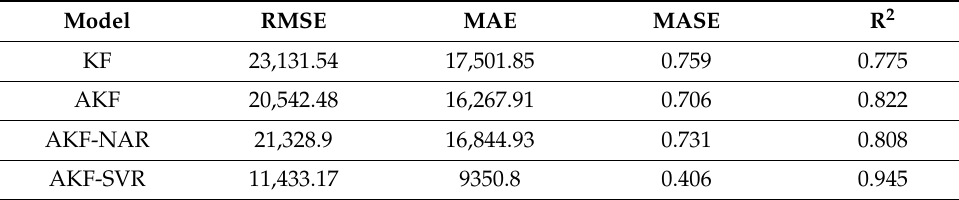
Figure 3. Prediction charts for total overnight visitors in Huelva: 2017–2019 (monthly). Table 4. Results for total visitors in Huelva: 2017–2019